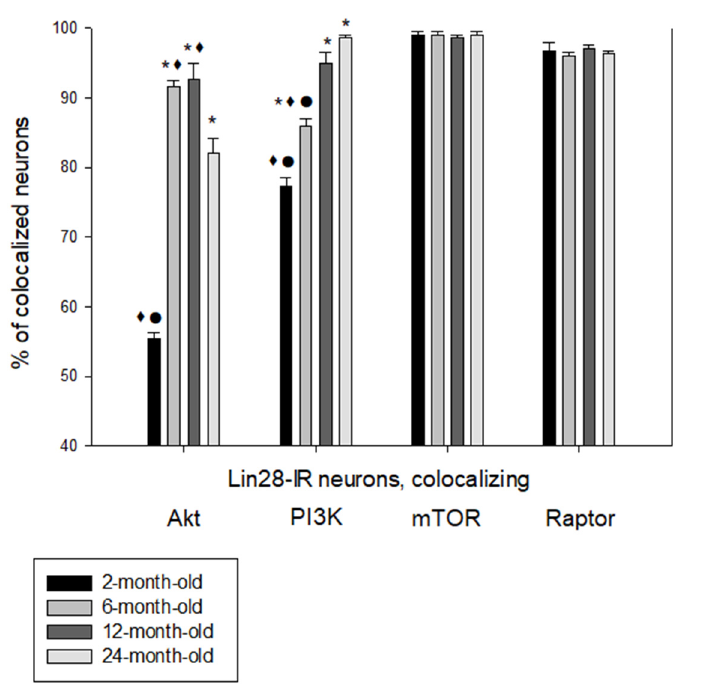
Figure 3. Percentage of Lin28-IR neurons, colocalizing AkT, PI3K, mTOR and Raptor in the VMH of rats of different age group. n = 5 per group (* p < 0.05, comparing 2-month-old rats; ● p < 0.05, comparing 12-month-old rats; ♦ p < 0.05, comparing 24-month-old rats). The proportion of Lin28/PI3K-IR neurons significantly increased from 77 ± 1.2 in 2- month-old rat to 86 ± 1.0 in 6-month-old rats ( p < 0.05) and subsequently to 96-99% in 12- month-old and 24-month-old rats ( p < 0.01, statistically significant differences between 6- month-old and 12-month-old rats) (Figures 3 and 5). Differences between 12-month-old and 24-month-old rats were not statistically significant ( p > 0.05). Nearly all Lin28-IR neurons (96–99%) colocalized mTOR and mTORC1 component Raptor without statistically significant differences in the all studied age groups ( p > 0.05) (Figures 3, 6 and 7).